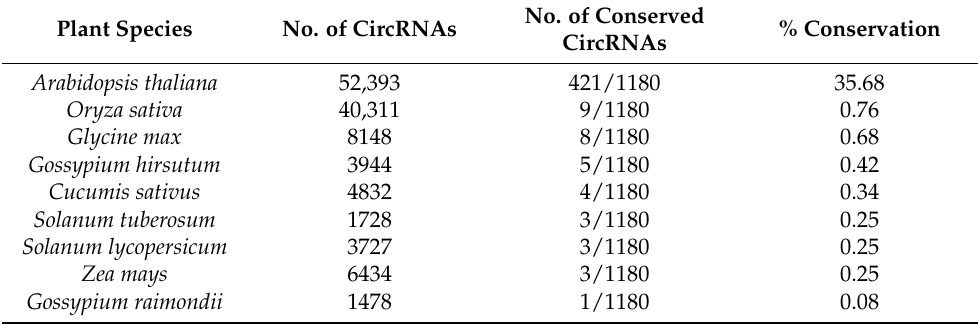
Table 1. Summary of conserved circRNAs between B. rapa and other plant species. Plant